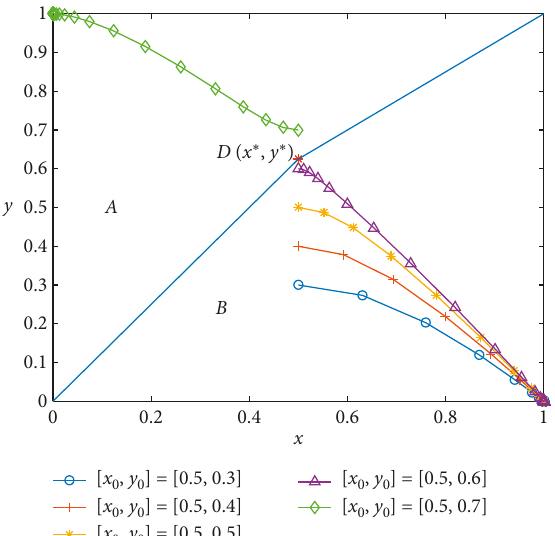
Figure 3: Influences of the changes in the initial value y evolutionary result.